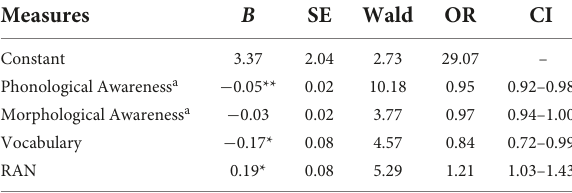
TABLE 5 Results of binary logistic regression predicting children’s RD.